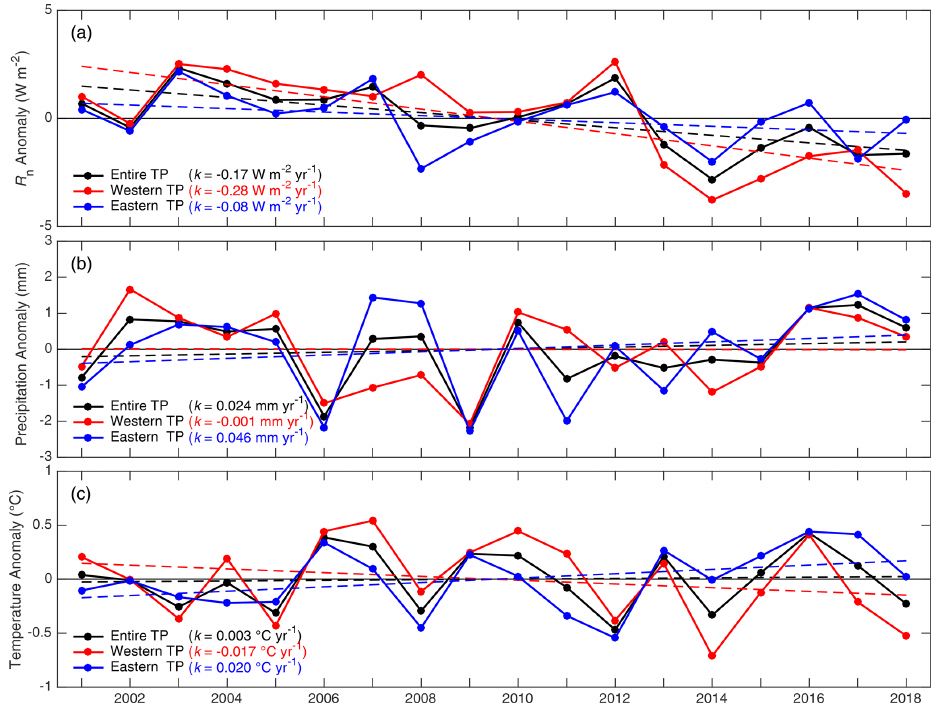
Figure 8. Domain-averaged anomalies of annual R n (a) , precipitation (b) , and temperature (c) over the entire TP, the western TP (long < 90 ◦ E), and the eastern TP (long > 90 ◦ E), respectively. The dashed straight lines indicate linear trends during 2001–2018, and k is the slope of the straight